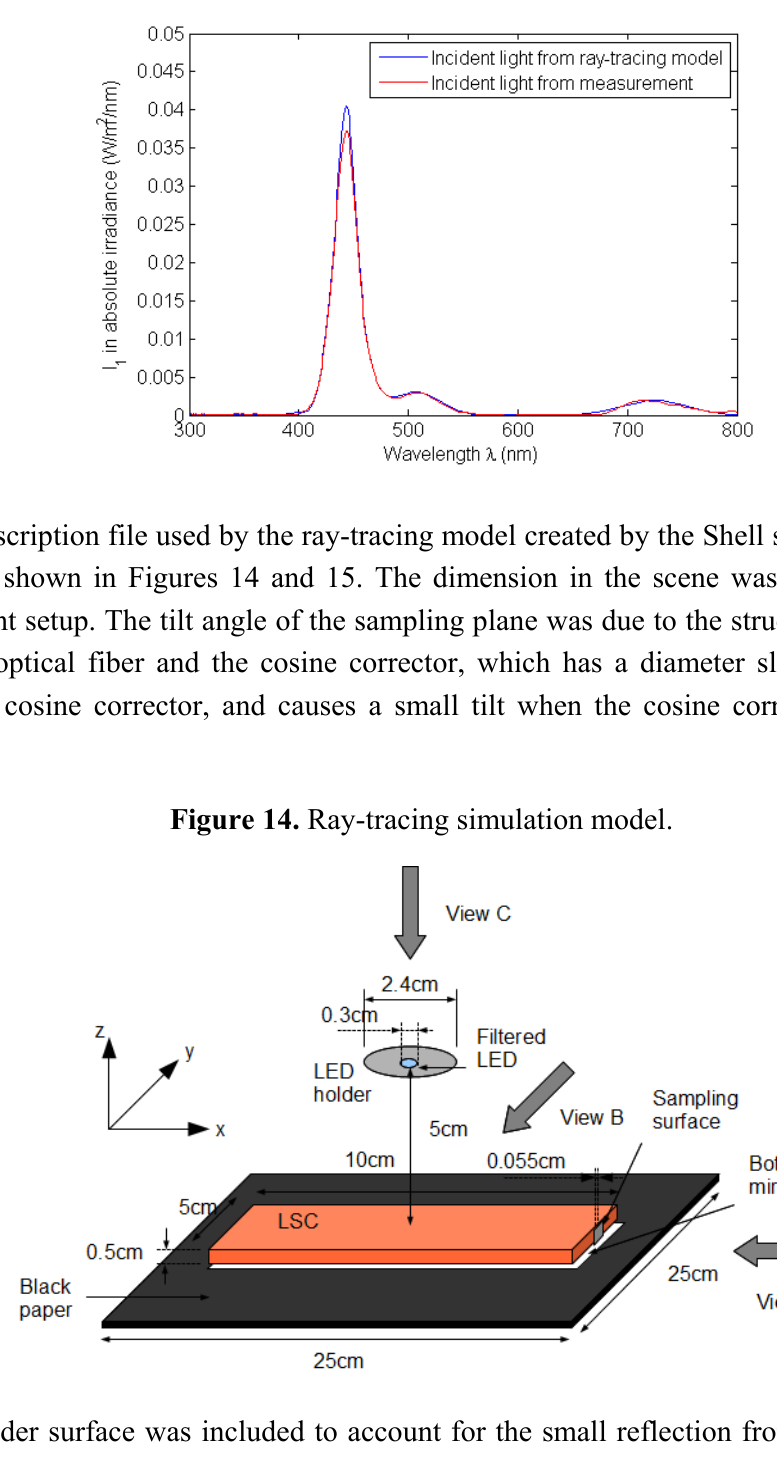
Figure 13. Incident light spectrum.